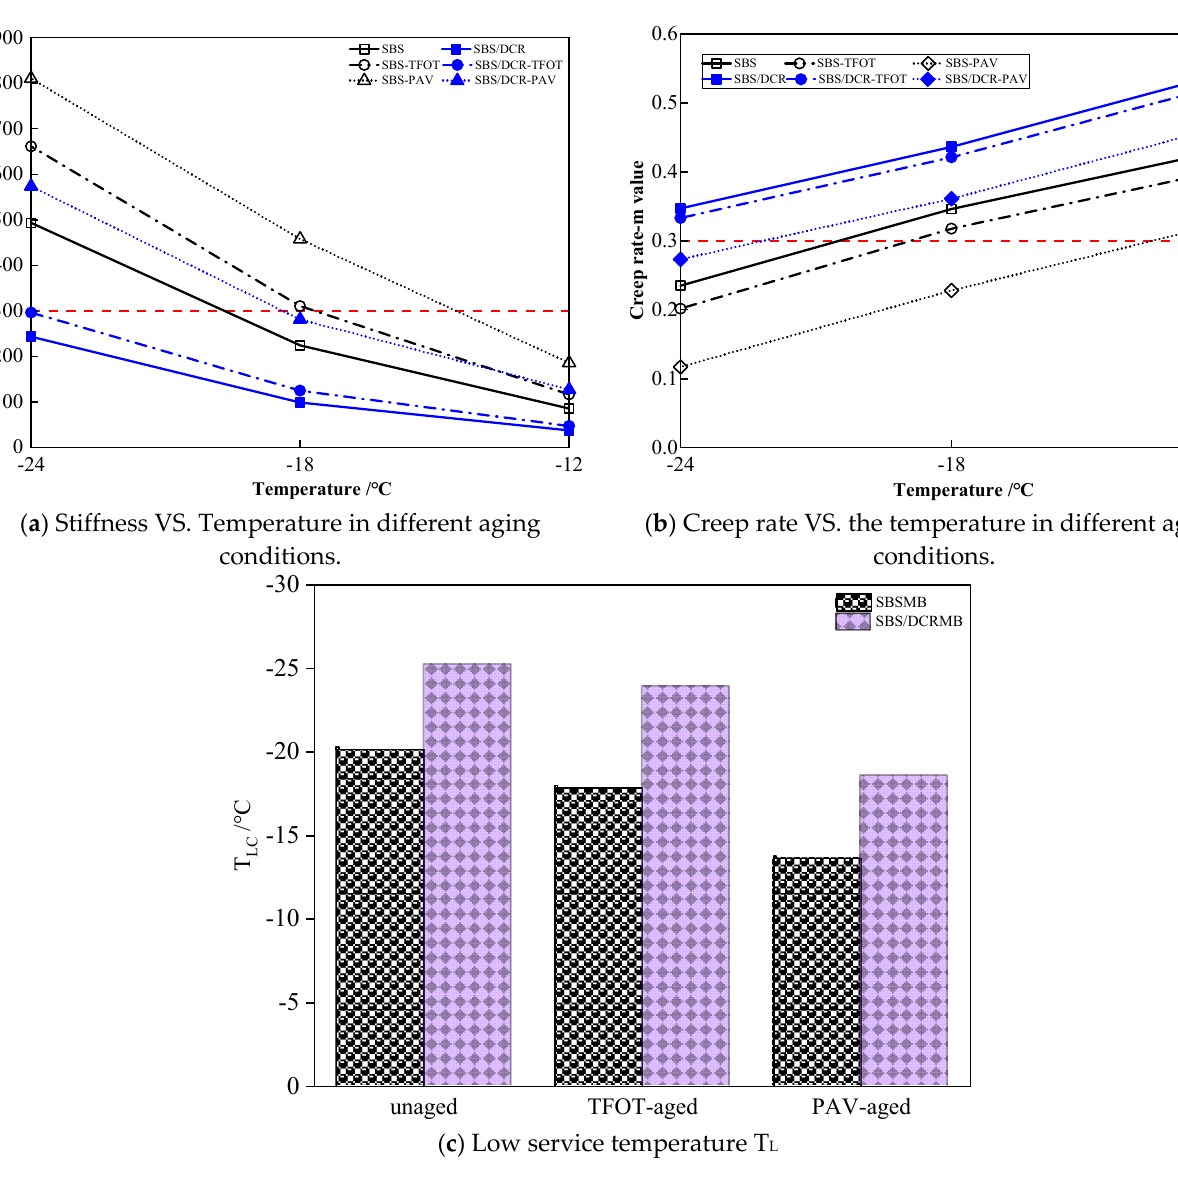
Figure 8. Low-temperature performance in bending beam Rheometer.